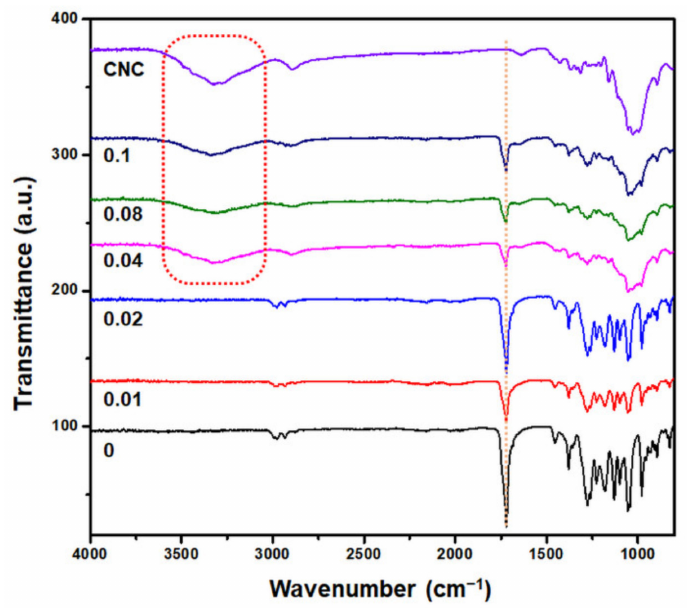
Figure 3. FTIR spectra of PHB synthesized by C. necator with different concentrations of CNCs.